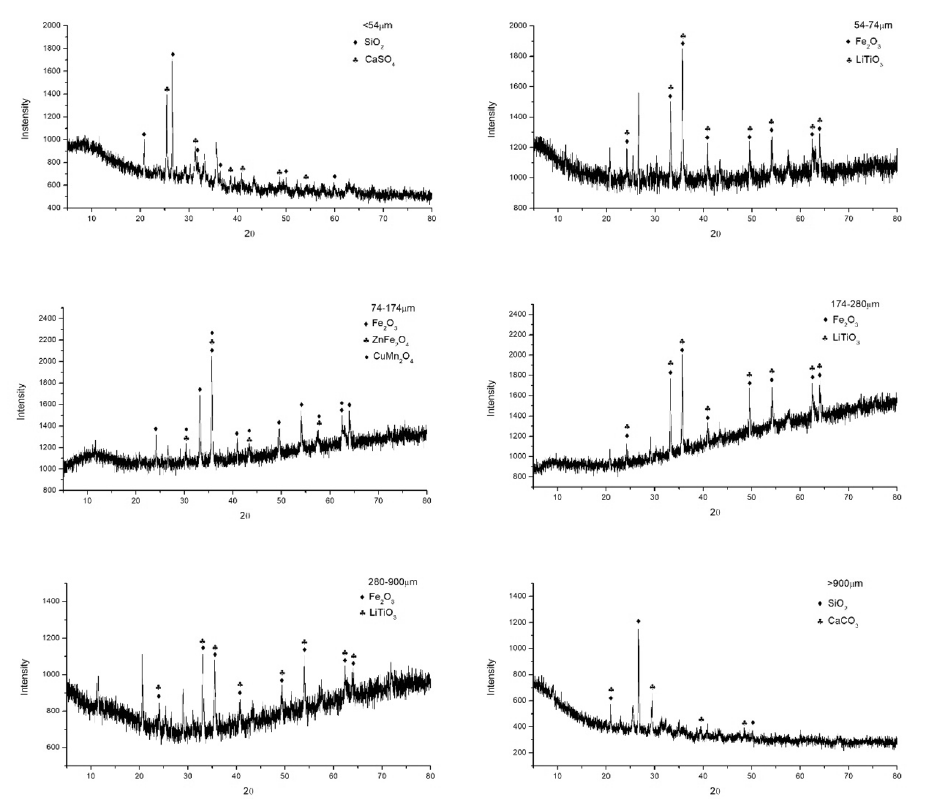
Figure 5. XRD spectrums of fly ash samples with different particle